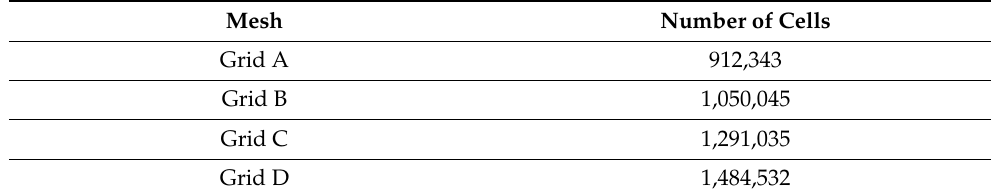
Table 1. The number of cells that are generated for each case.